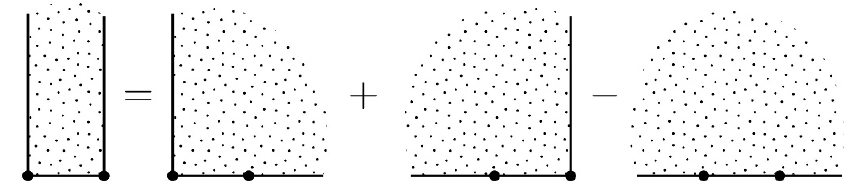
Figure 13 . An example of the polyhedral decomposition into cones, theorem